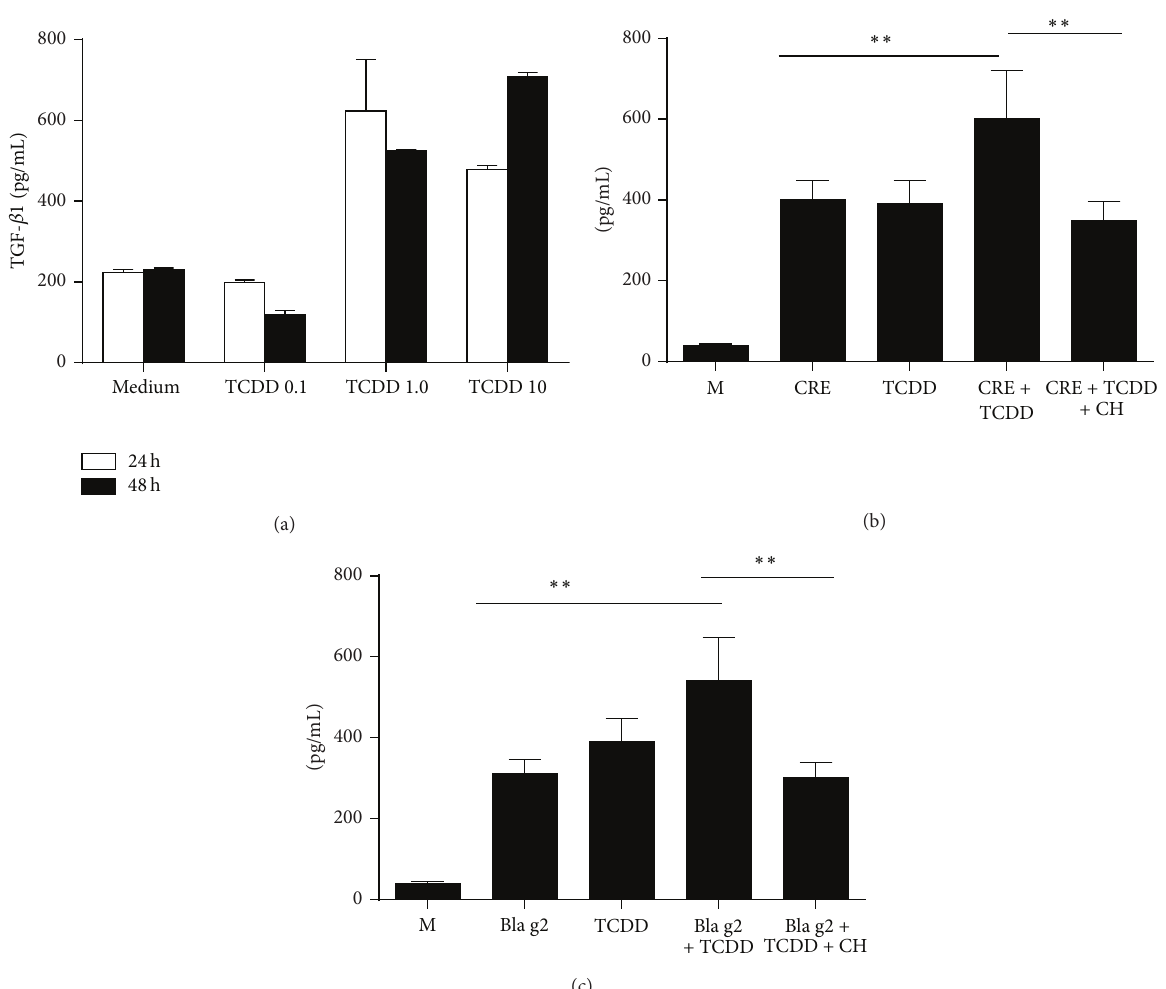
Figure 3: AhR modulates cockroach allergen-induced TGF 𝛽 1 production. (a) TCDD can induce TGF 𝛽 1 secretion by fibroblasts and (b) cockroach allergen-induced TGF 𝛽 1 secretion by fibroblasts can be further enhanced by TCDD but inhibited by AhR antagonist CH122319 (c). (c) Cockroach allergen-induced TGF 𝛽 1 production and the inhibitory role of CH122319 were further confirmed when Bla g2 was used. Bars represent mean ± SEM of 3 independent experiments. ∗ 𝑃 < 0.05 , ∗∗ 𝑃 < 0.01